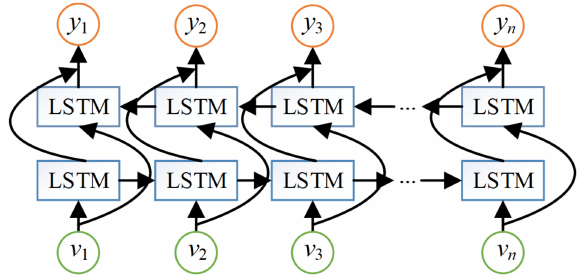
Figure 5. BiLSTM neural network structure